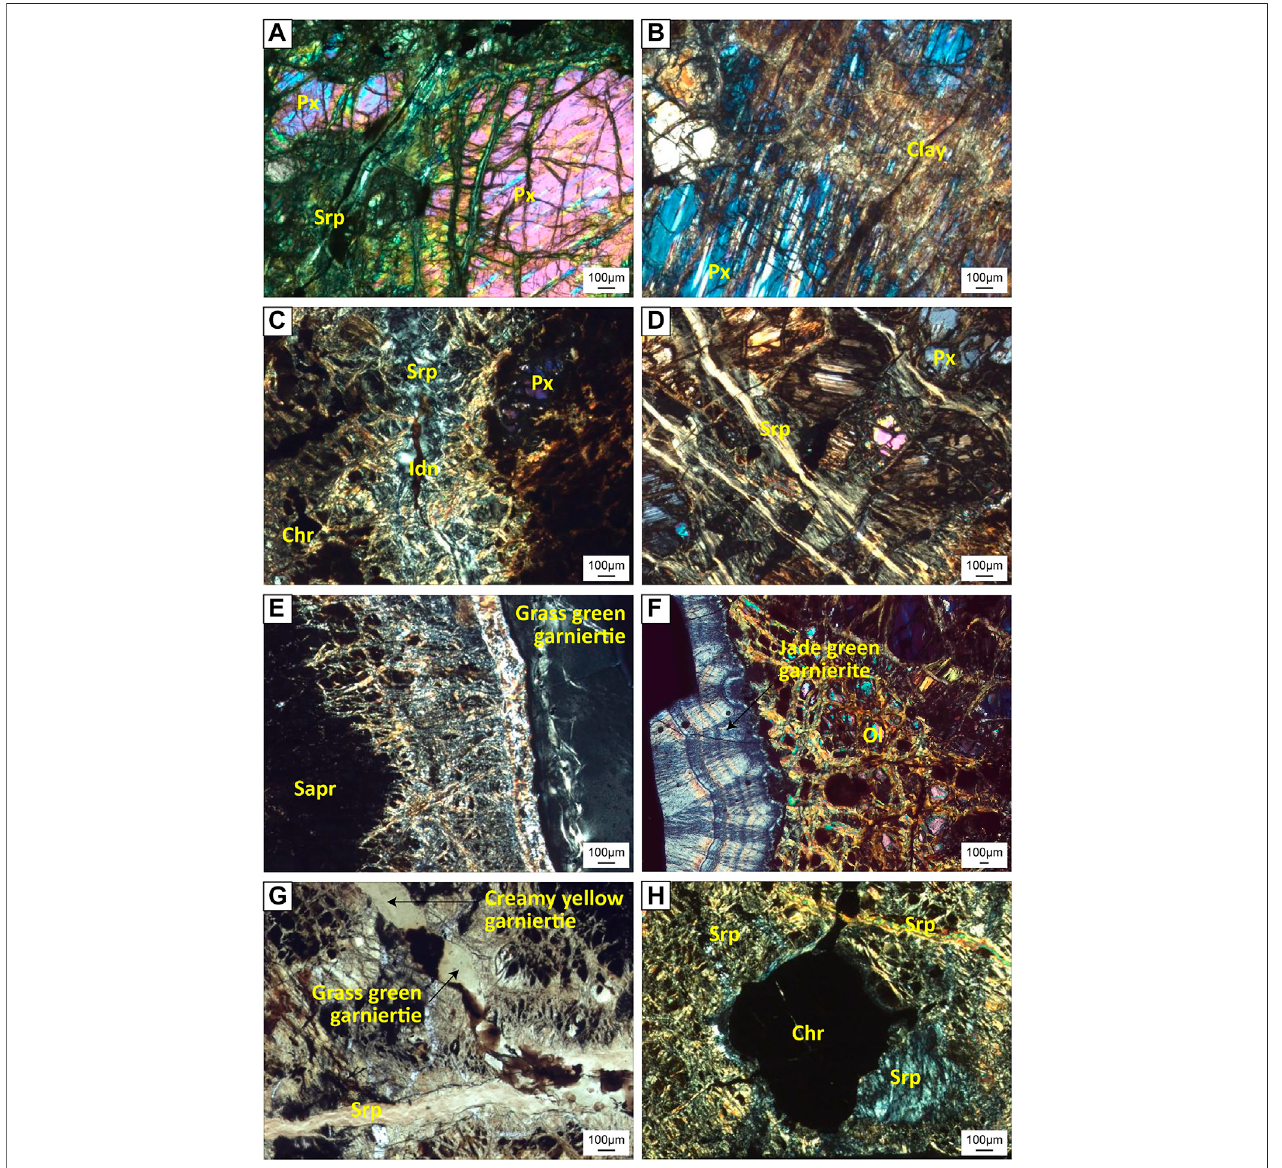
FIGURE3| PhotomicrographsoftheMorowalidepositsamples.Allphotomicrographsexcept (G) weretakenundercross-polarizedlight(XPL). (A) phenocrystsof orthopyroxene surrounded by serpentine (B) altered orthopyroxene with clinopyroxene exsolutions (C) serpentine and development of iddingsite (D) serpentine vein crosscutting the bedrock (E) and (F) development of grass green and jade green garnierite (G) veins of serpentine and creamy yellow garnierite (H) anhedral chromite phenocryst surrounded by serpentine. Abbreviation: Px (cid:1) pyroxene, Srp (cid:1) serpentine, Idn (cid:1) iddingsite, Chr (cid:1) chromite, Sapr (cid:1) saprolite.